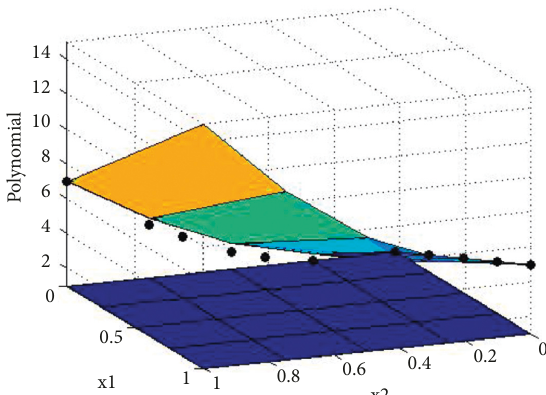
Figure 2: The surface of a bi-variate polynomial over the standard simplex, the coefficients of Bernstein marked by black points, and the minimum enclosure bound (blue surface) bounds its polynomial surface over the whole